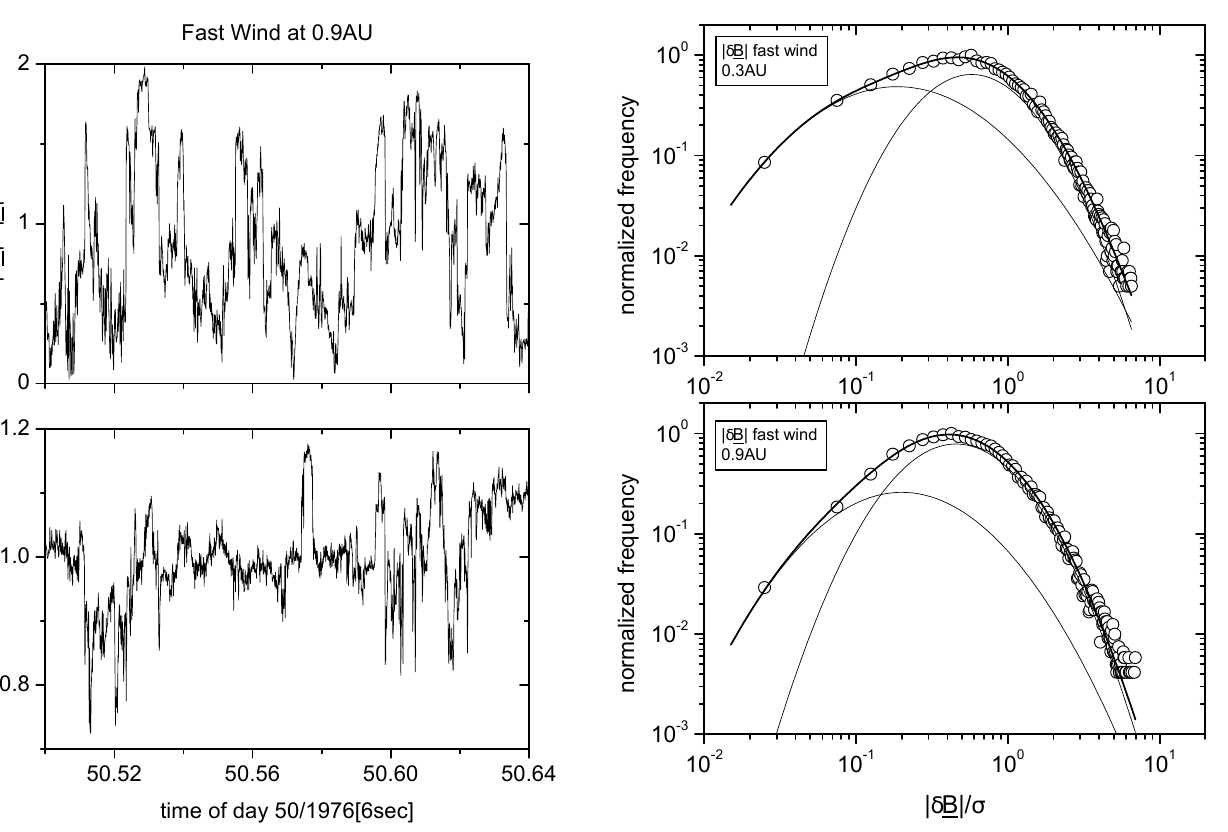
Fig. 7. Normalized vector displacements and normalized vector in- tensity versus time are shown in the same format of Figs. 4–6 for a fast wind at 0.9AU. Vector displacements shown in the top panel appear to be less chaotic than those observed at 0.3AU. A sort of underlying structure can be recognized and related to field inten- sity fluctuations shown in the bottom panel. In other words, this situation tends to resemble the one encountered within slow wind.